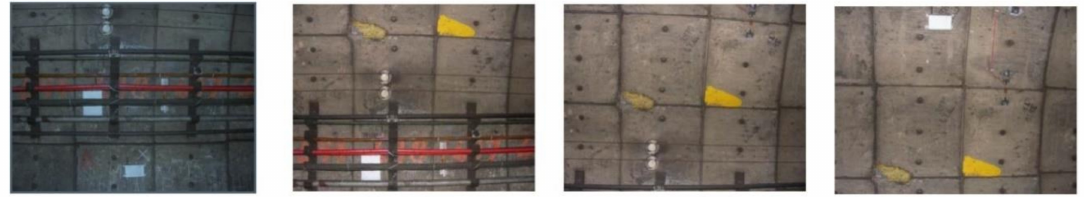
Figure 4. Example of video frames from Xiaoyadaokou tunnel, China [56].